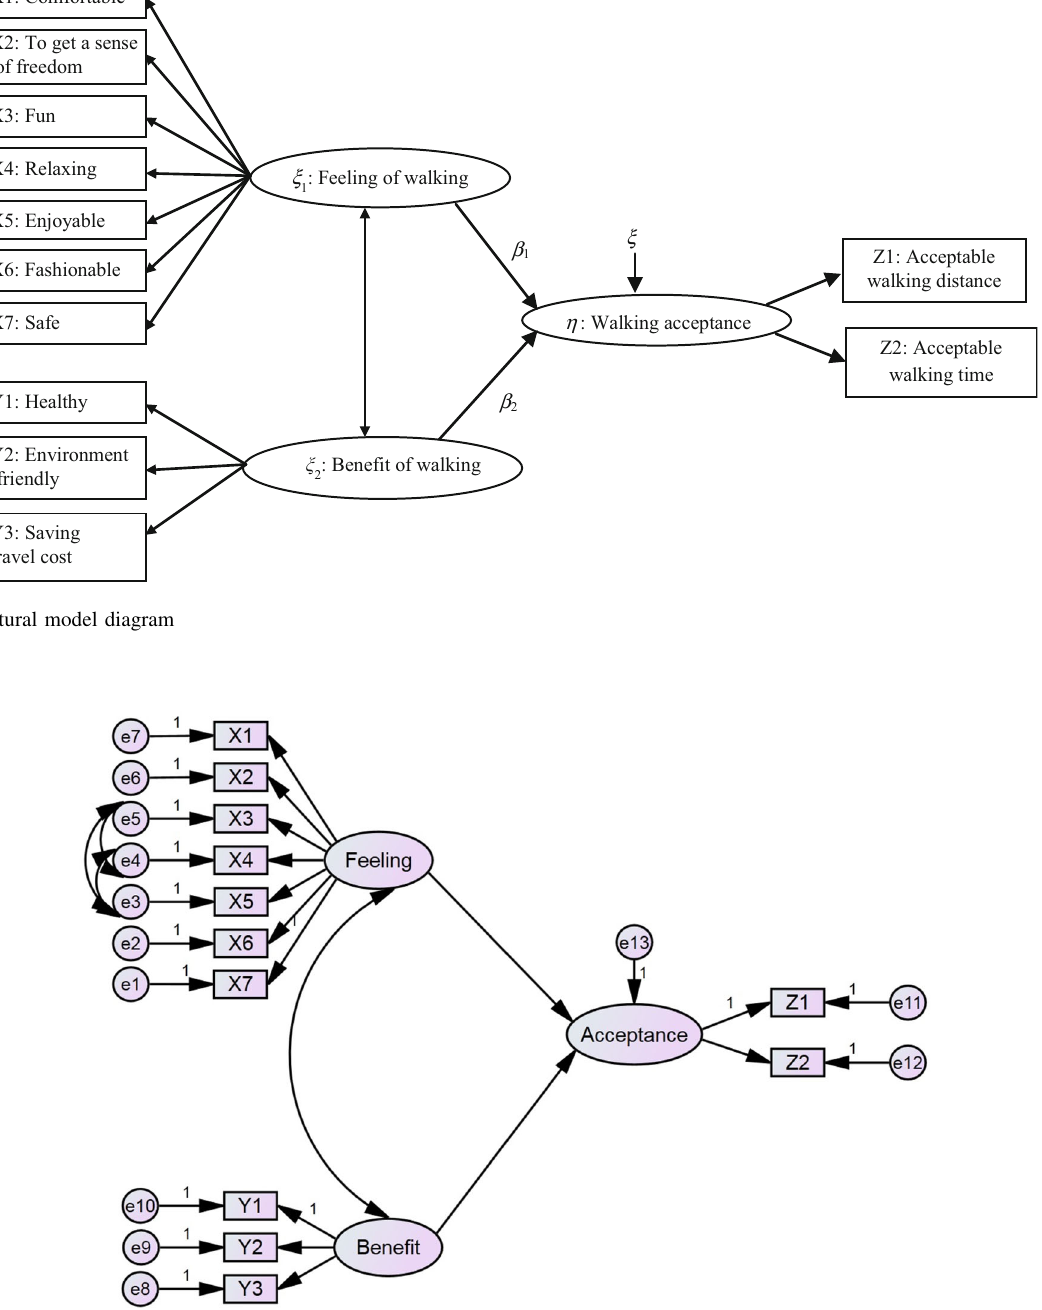
relationship of latent variables, ‘‘feeling’’ and ‘‘benefit’’ positively influence ‘‘walking acceptance’’ with signifi- cance at p \ 0.05 (95% of confidence level). The beta coefficients of b and b are 0.381 and 0.287, 1 2